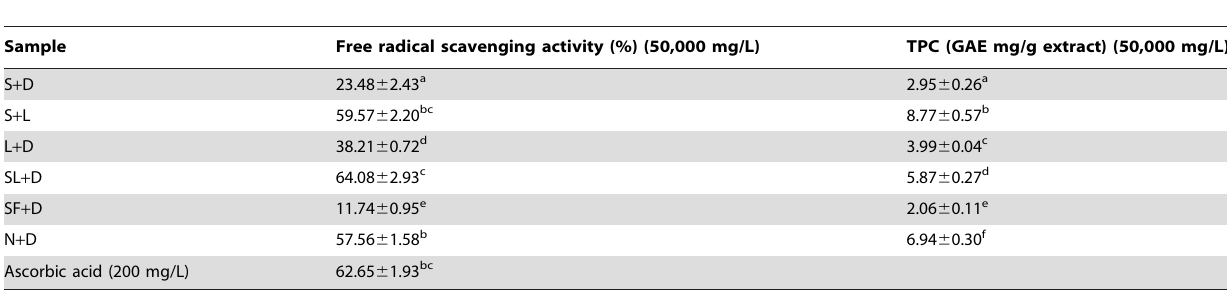
Table 6. Antioxidant ability and total phenolic content of the 70% methanol extracts of C. pruinosa mycelium grown in different cultivation